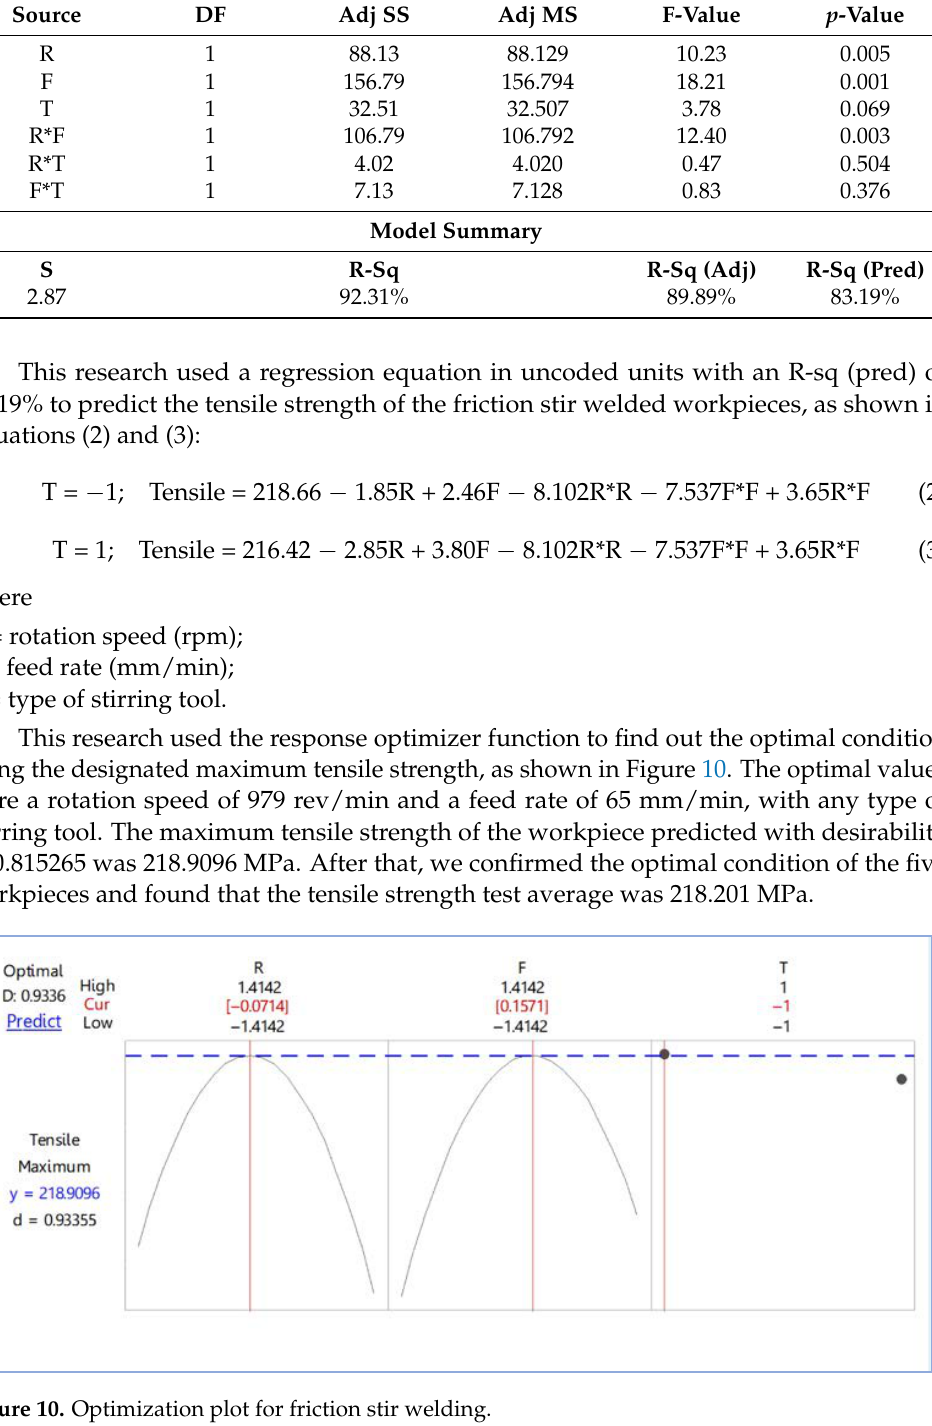
Table 7. Tensile strength test of the deep-rolled workpiece.